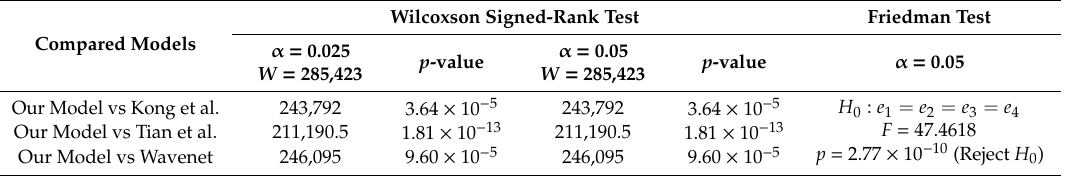
Table 7. Result of the Wilcoxon signed-rank test and Friedman test using ENTSO-E testing dataset 2. Compared Models